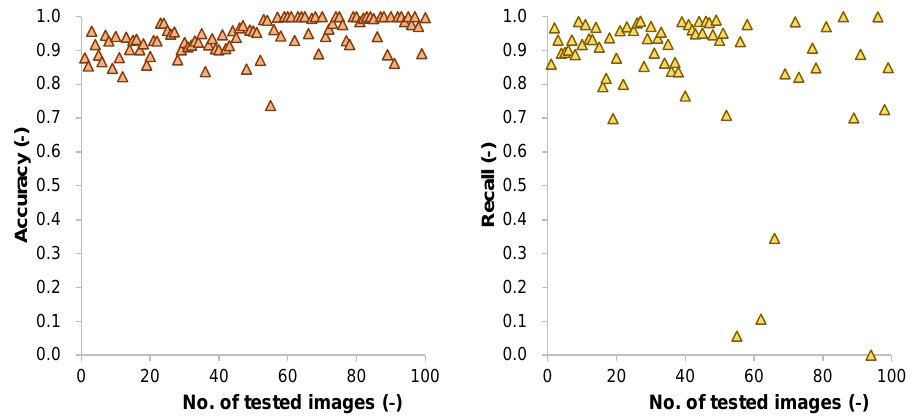
Figure 6. Accuracy and recall values of the randomly selected test dataset.